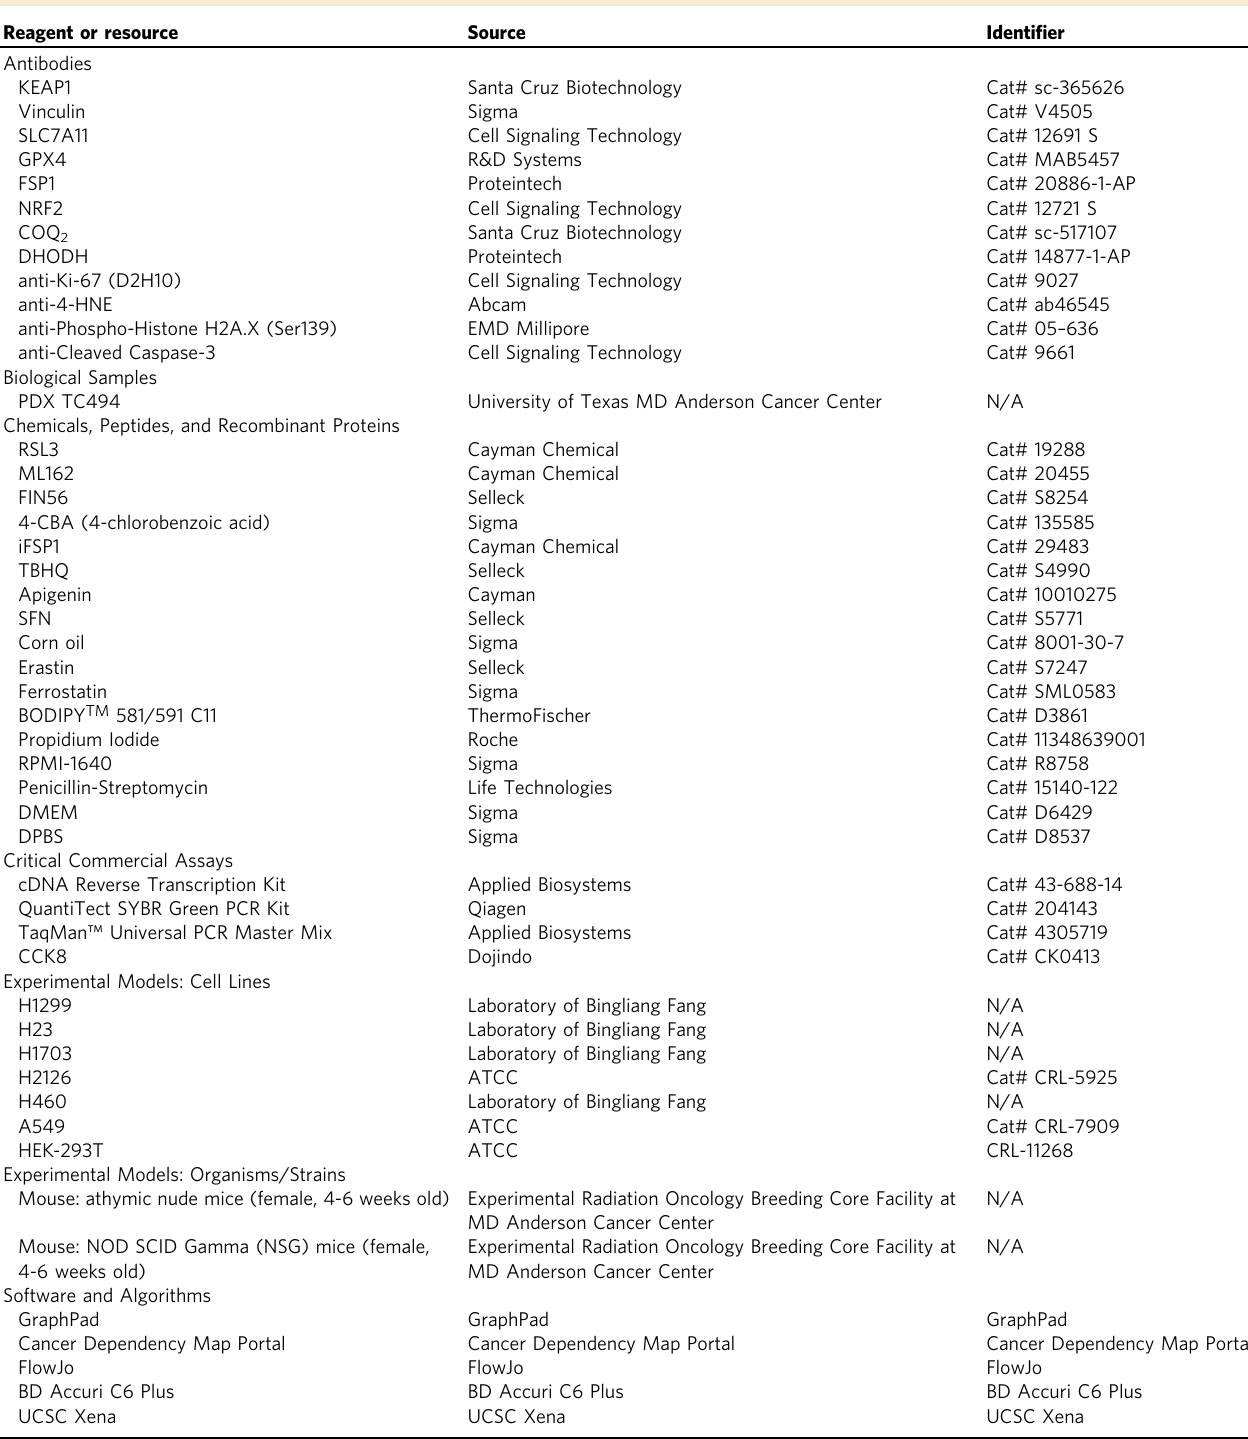
Table 1 Key resources